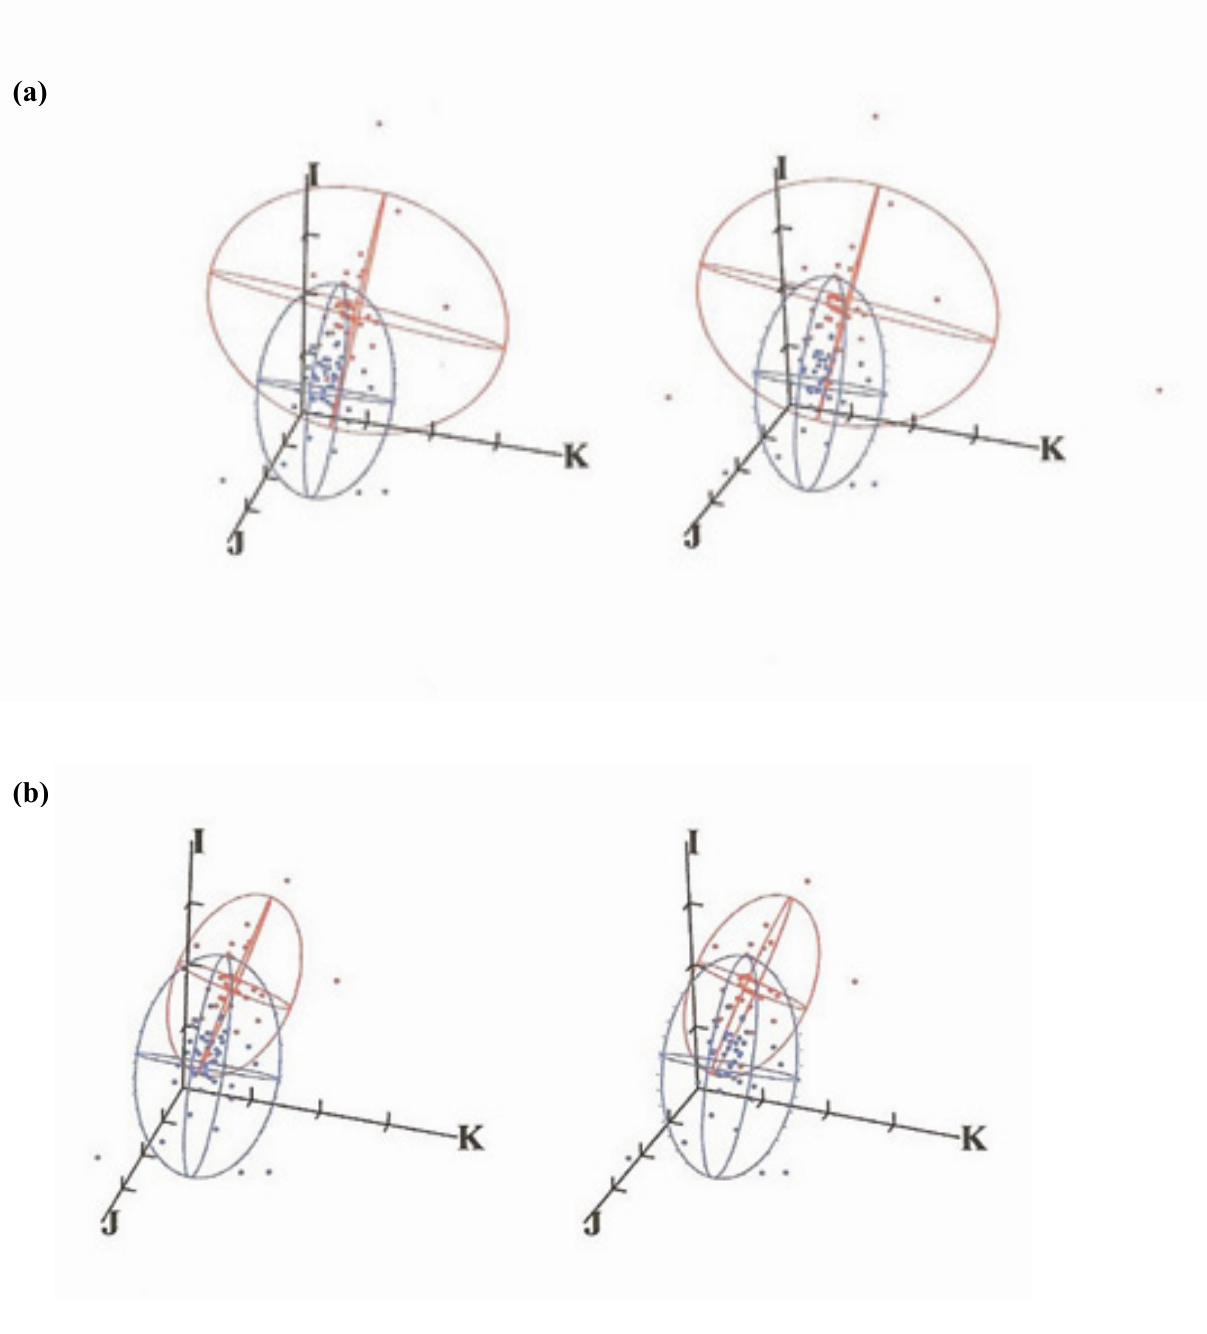
Figure 2 . Two stereo-pair scatter plots for Subject 1 showing the keratometric measurements obtained using an autokeratometer (red) and Pentacam (blue) with ( a ) and without two outliers ( b ). For both plots the origin of the axes is set at the power 43 D (in conventional terms) and the tick interval is 0.25 D. Removal of the outliers reduces the volume of the red ellipsoid and changes its